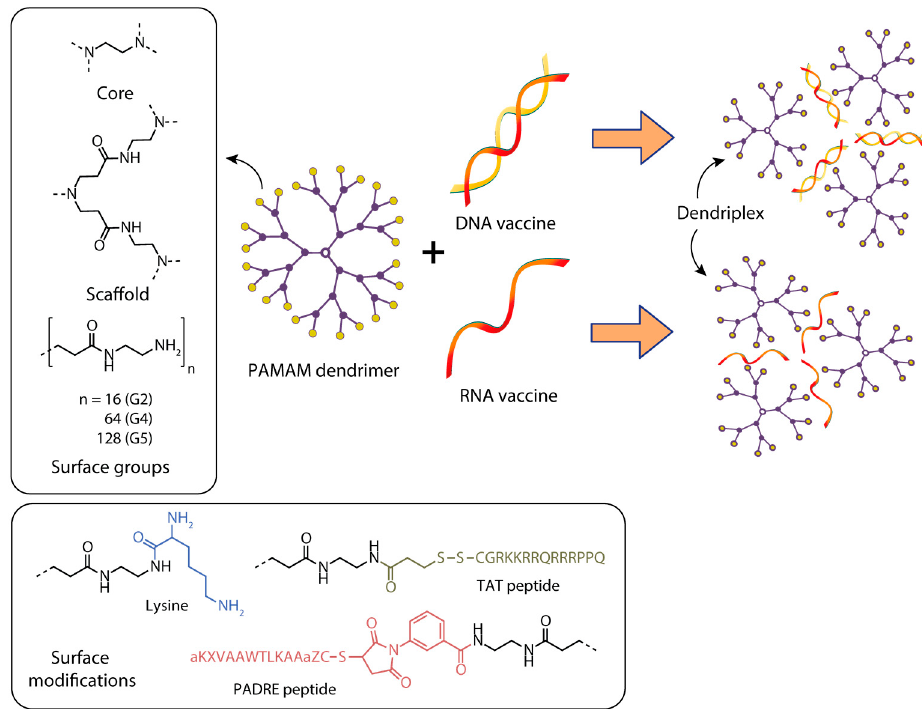
Figure 6. Constructing vaccine nanoformulations based on PAMAM dendrimers. DNA vaccines are present among plasmids encoding arti fi cial multi-epitope T-cell